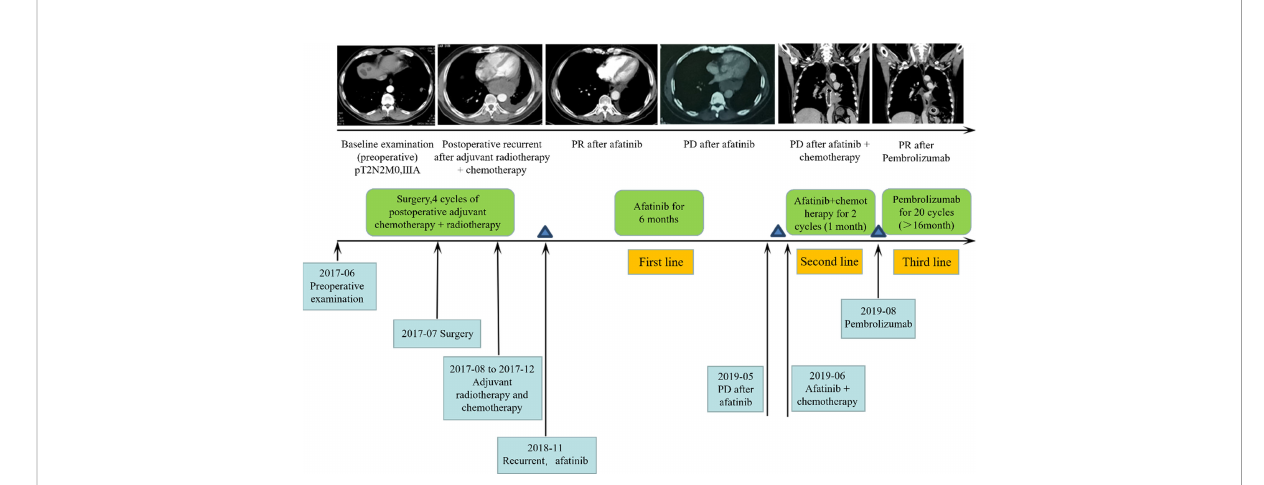
FIGURE 8 Clinical response for third-line immunotherapy in a patient with uncommon type EGFR